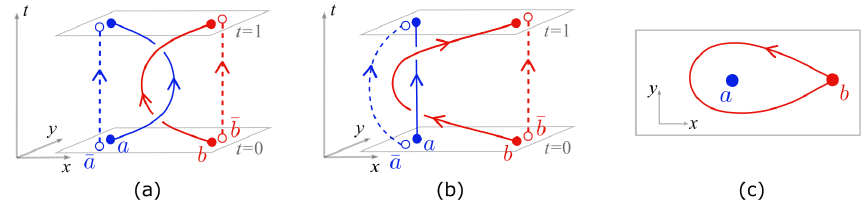
Figure 1 . Braiding of two particles (e.g., anyons) in 3 D spacetime, world-lines of particles and their projection in 2 D space. (a) At t = 0 , two pairs of particles (solid circles) and antiparticle (empty circles) are created. Two particles ( a and b ) move in 3 D spacetime such that their world- lines (solid lines) cross each other. At t = 1 , two particles meets their own antiparticles ( ¯ a and ¯ b ). The a - ¯ a and b - ¯ b pairs are annihilated. Since the world-line of an antiparticle (dash line) can be understood as that of a particle with a reverse direction, the particle-antiparticle pair’s world-lines can be viewed as a single closed one of the particle. For a braiding process of two particles in 3 D, the two closed world-lines are linked. (b) One of the two particles (e.g., a ) can be assumed static in the xy -plane. By slightly modifying the world-line of b and keeping the two closed world- lines linked, the braiding process contributes the same phase shift. (c) The world-lines of a and b illustrated in (b) are projected to the xy -plane. After that, b ’s world-line is appeared as a closed spatial trajectory encircling the static particle a . In FQHE, an anyon moving around another one is exactly the braiding of